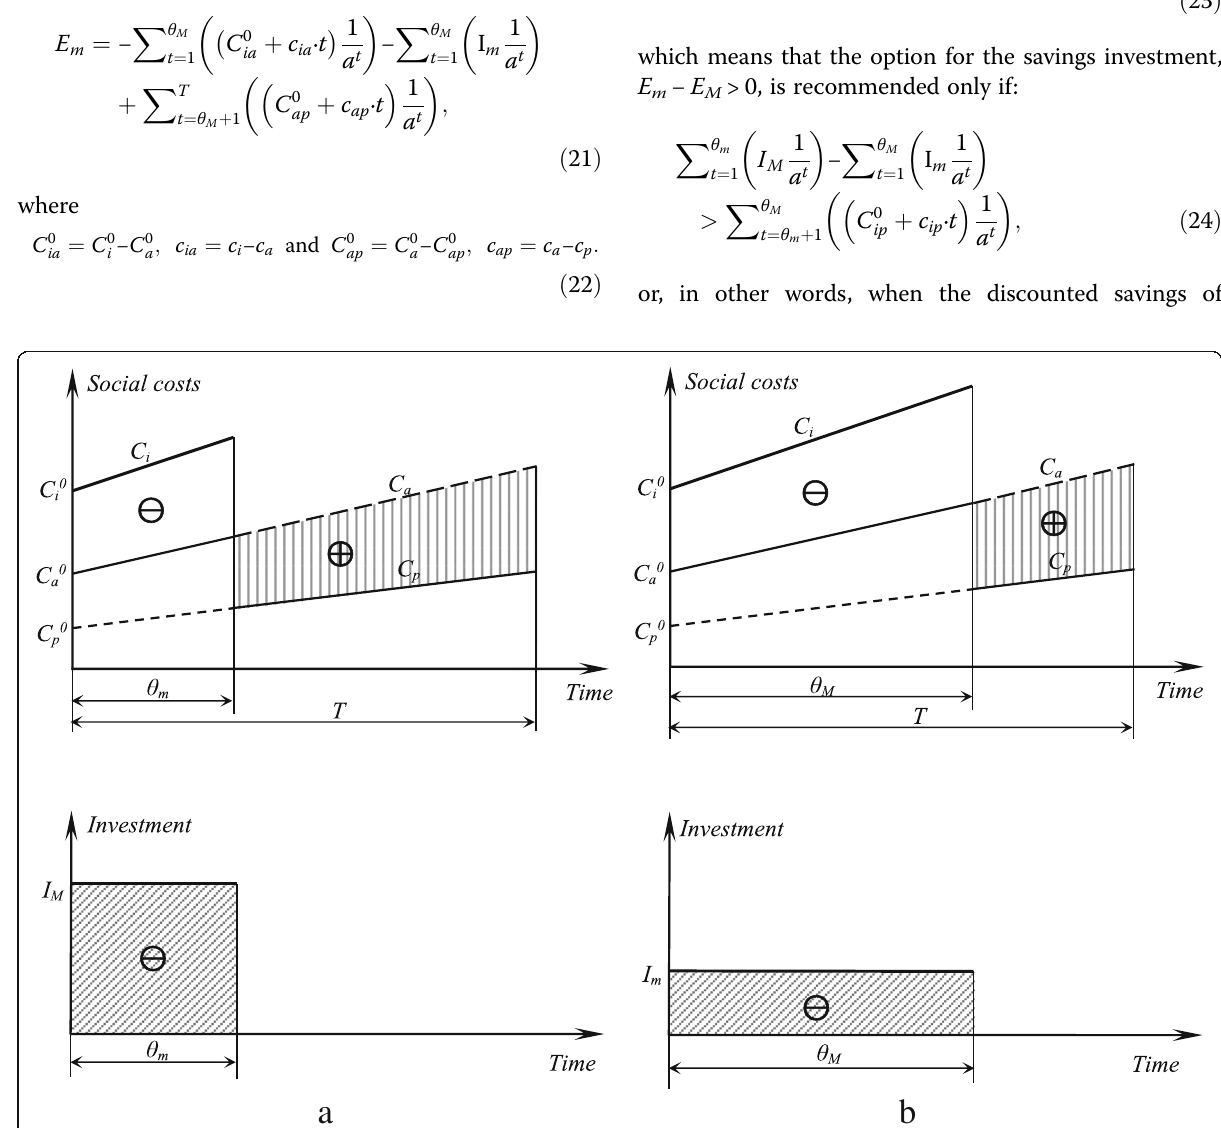
Fig. 7 Investment amount, additional social costs and savings of the social costs after the completion of the work for both options. a Minimum time for work. b Maximum time for